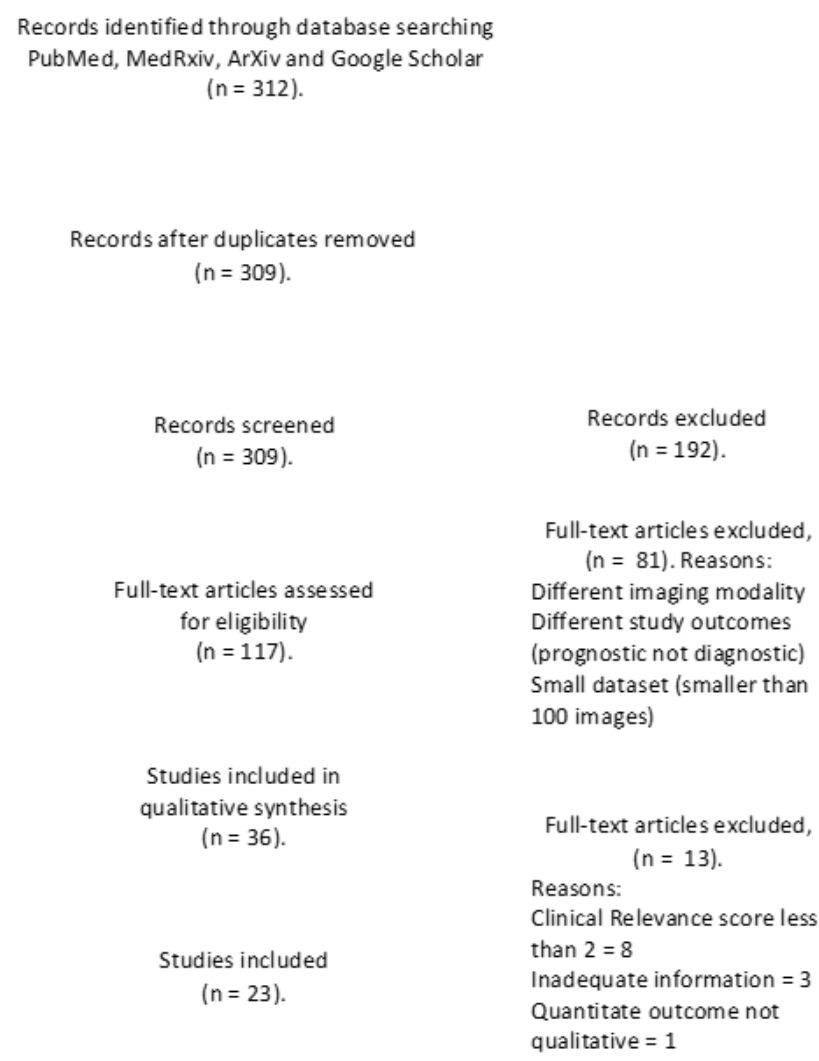
Figure 1. PRISMA flow chart displaying the selection process of chosen studies, including total identified records, number screened, number of duplicates, included and excluded records for inclusion.